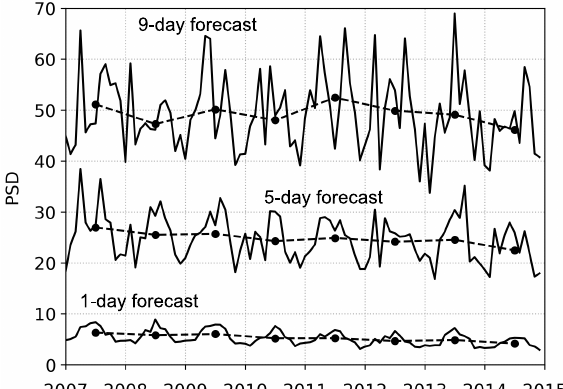
Figure 7. Analysis of time-series of ECMWF precipitation forecasts. Monthly (solid line) and yearly (dash-dotted line with circles) averages of PSD values for the 6-h precipitation accumulations (0000–0600 UTC) in the period